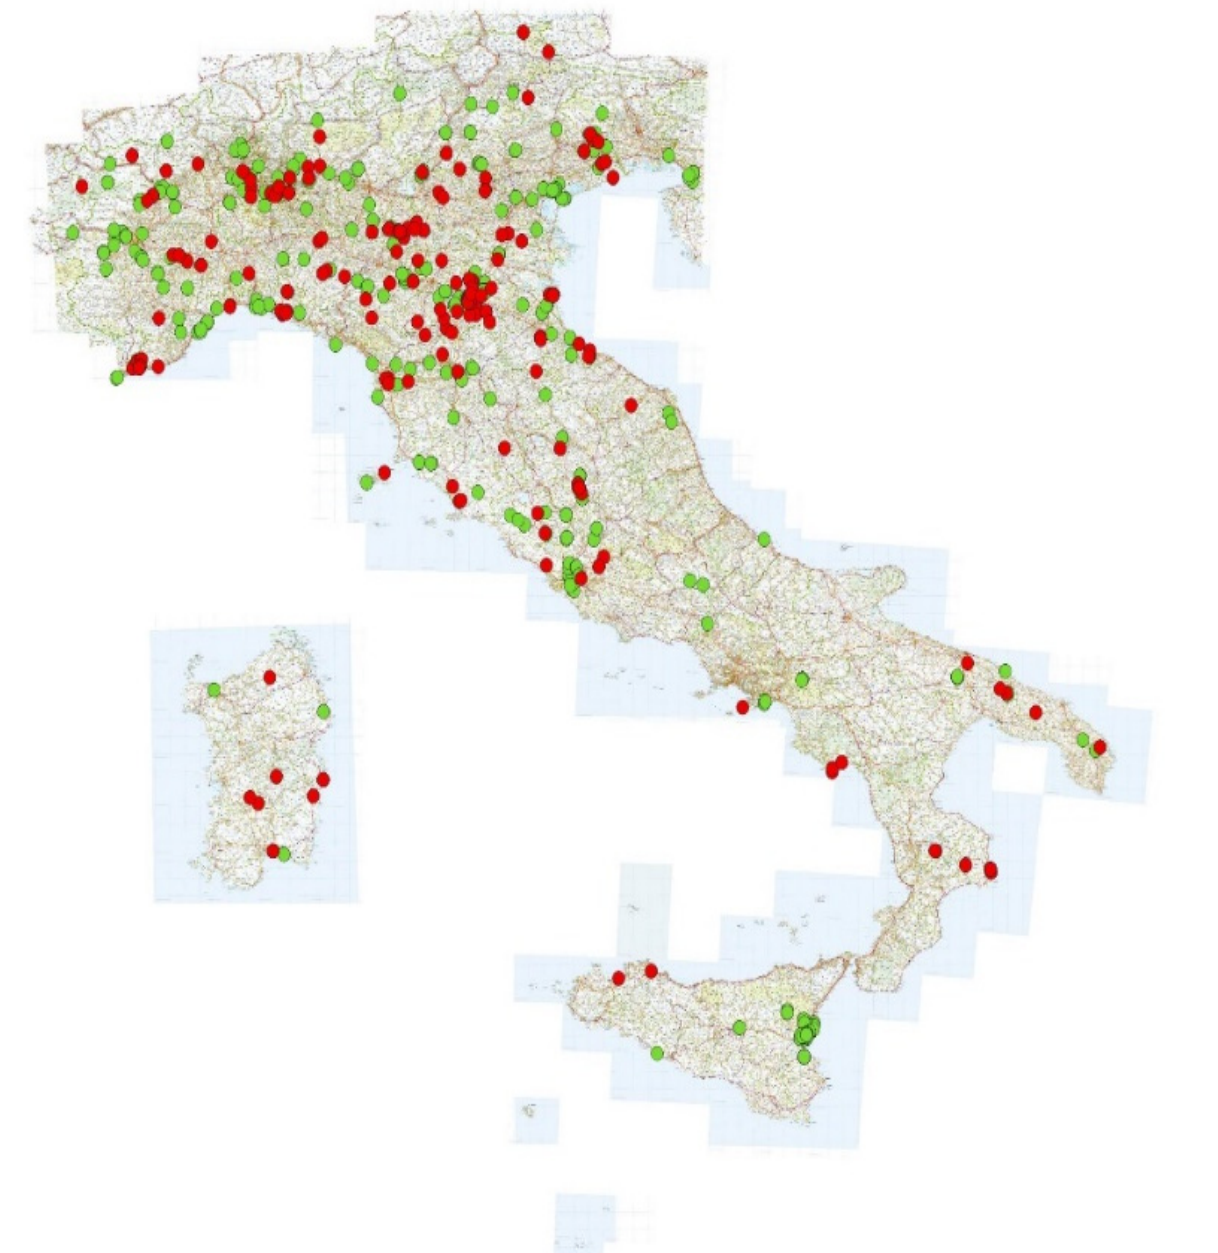
Figure 2. Map of the reports sent in the years 2019 (red dot) and 2020 (green dot).